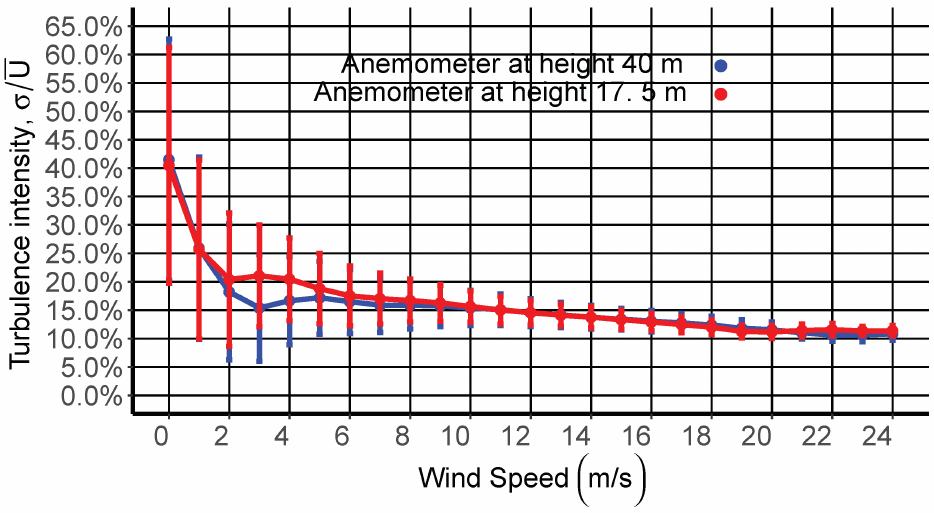
Figure 8. Turbulence intensity, σ / ¯ U , variation through measured heights: 17.5 and 40 m.